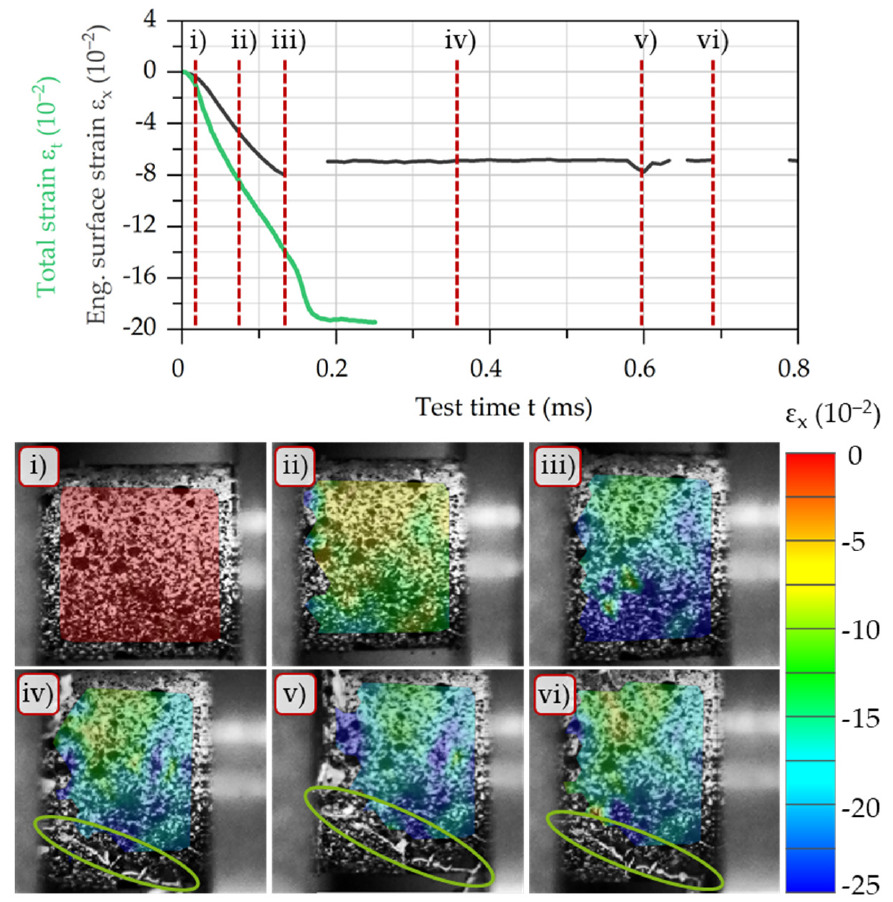
Figure 11. Specific states of the measuring curve for the Ti6Al4V alloy. Bulging at the circumference of the specimen, which was observed in particular for Ti6Al4V alloy, was identified as the main mechanism of the inhomogeneous specimen deformation as well as the main reason for non-compliant measurements between the two methods. Figure 12 compares the bulging of AISI 1045 and Ti6Al4V based on the radii formed. While the radius for AISI 1045 steel is of insignificant magnitude (r = 28 mm) compared to the ideal conditions of an infinite radius, for Ti6Al4V alloy it is r = 17 mm and therefore significantly more bulged. Typically, this bulging is attributed to the friction between the bars of the SHPB and the specimens [9]. However, in this case, Ti6Al4V